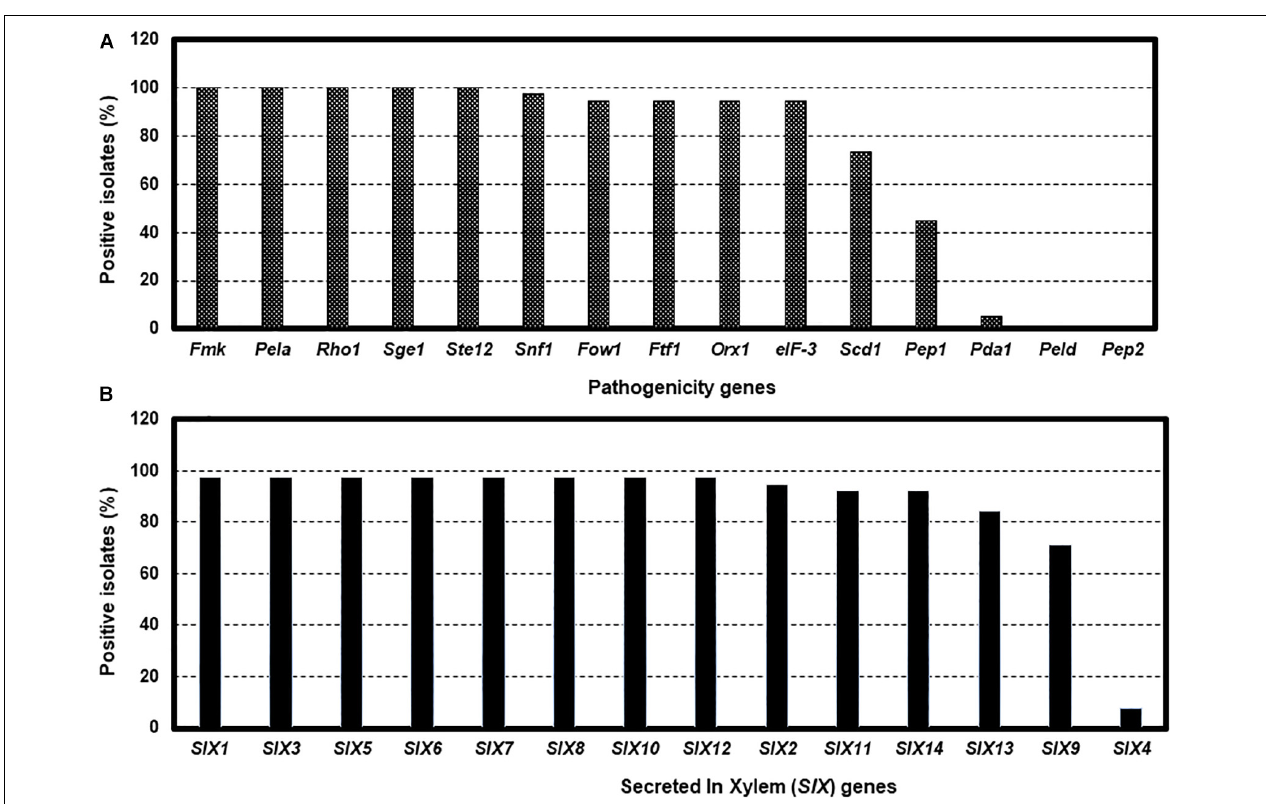
FIGURE 4 | The presence of polymerase chain reaction (PCR) assays targeting the pathogenicity genes and SIX genes in the 38 isolates of Fusarium oxysporum f. sp. lycopersici collected from the 12 tomato greenhouses in North Carolina. The presence was defined as the detection of PCR amplicons and sequences of each gene. The presence of 15 pathogenicity genes (A) , and the presence of 14 SIX genes (B)